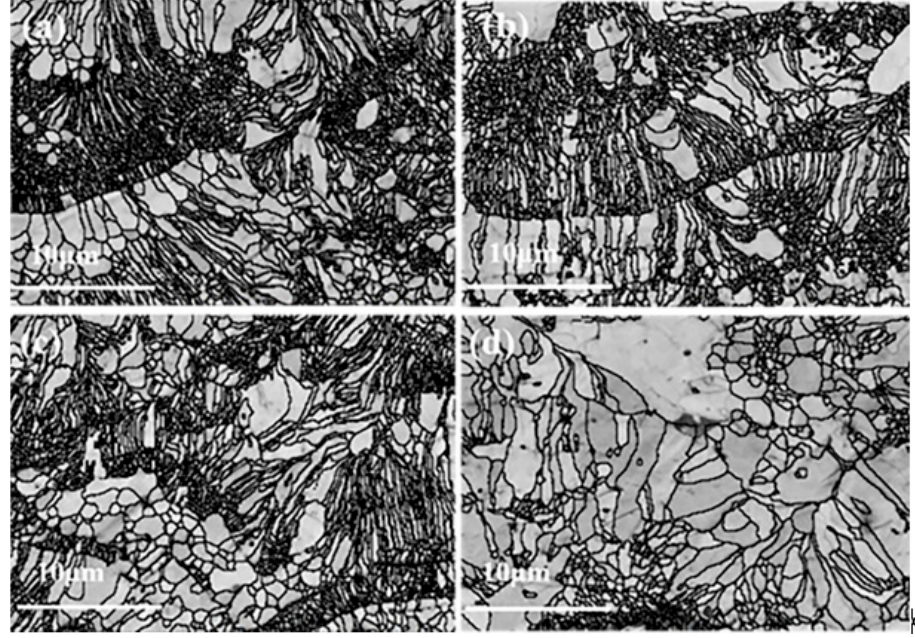
Figure 5. Bond contract of ( a ) N1, ( b ) N2, ( c ) N3, and ( d ) N4.